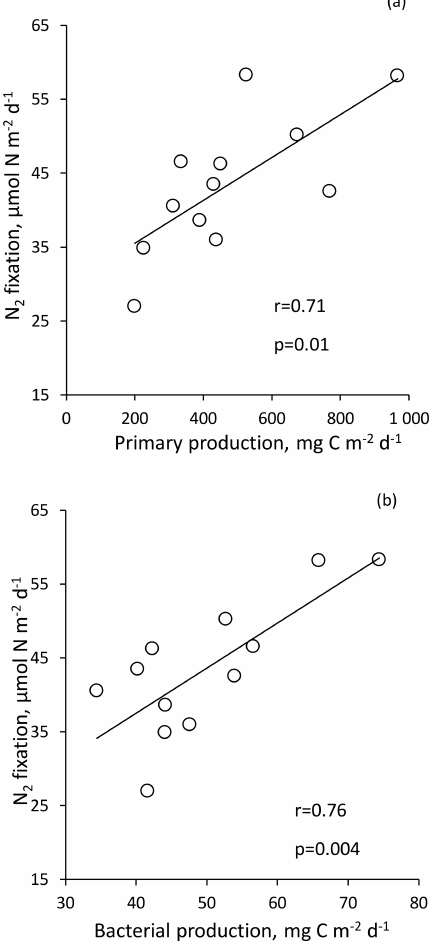
Figure 5. N 2 fixation rate integrated over the euphotic layer versus 13 C primary production (a) and bacterial production (b) ; data at Station 10 were